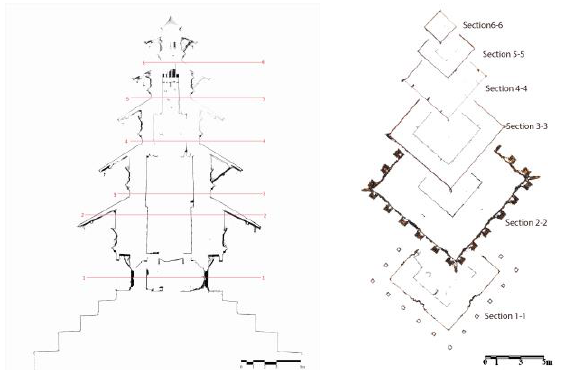
Figure 10. Schematic representation E-W section of Nyatapola temple and the floor plans generated from the point cloud